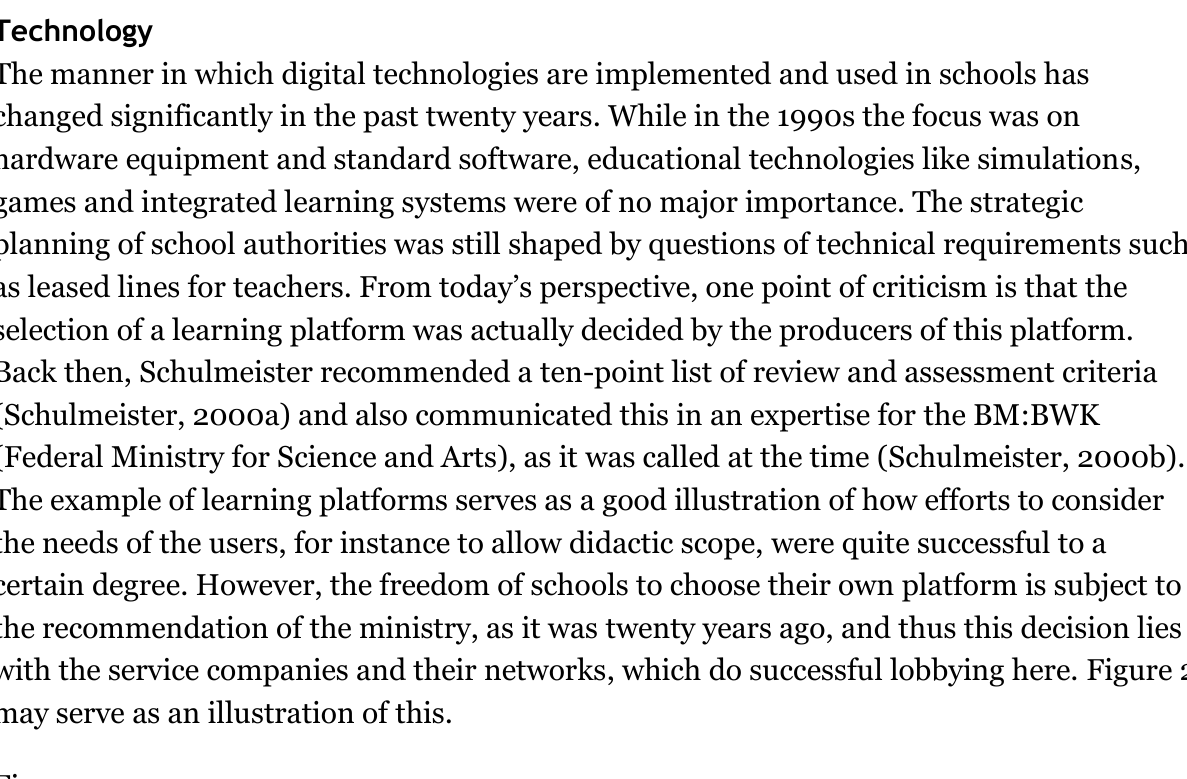
Step 1 of the online registration at https://serviceportal.eeducation.at/ (Source: